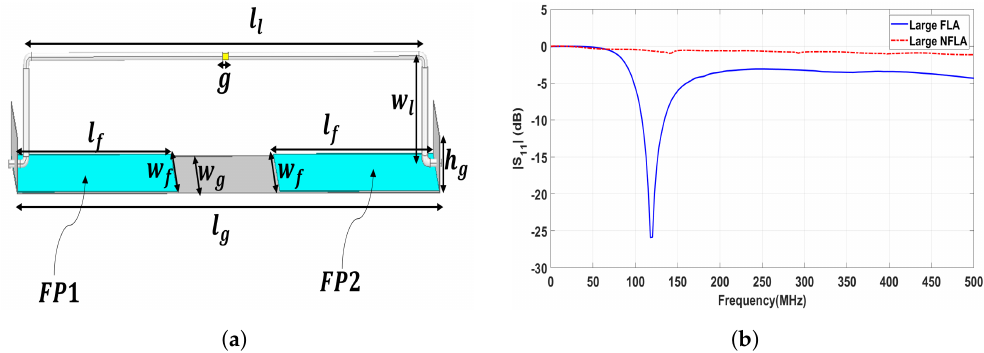
Figure 14. ( a ) Dimensions of the large FLA in mm are: w g = 56; l g = 160; h g = 10; w f = 56; l f = 100; l l = 140; w l = 30; g = 1. Note that aqua colors, two regions with dimensions l f × w f (= w g ) , are Ferrite Plates (FP1 and FP2). They both have a thickness of 2.2 mm which has not been shown in the figure. ( b ) Measured magnitude of the reflection of large FLA and large NFLA.